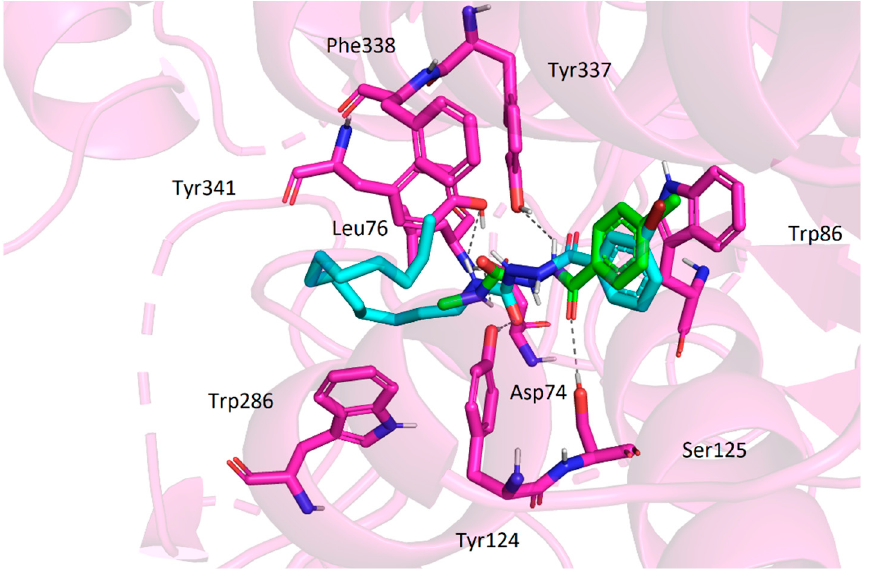
Figure 2. Conformation of 1e (green) and 2j (cyan) in the active site of AChE and surrounding amino acid residues.